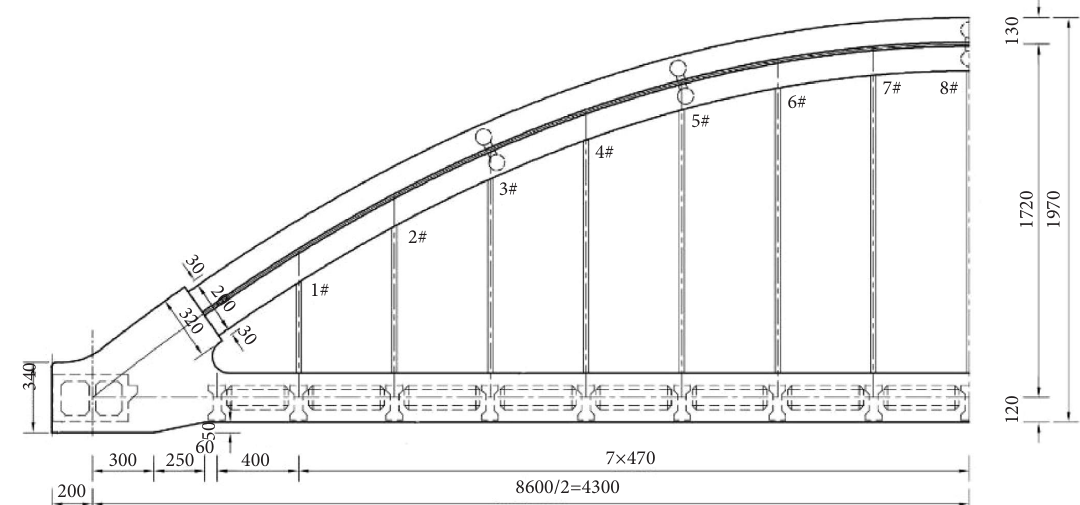
Figure 2: Overall view of the analyzed bridge (half